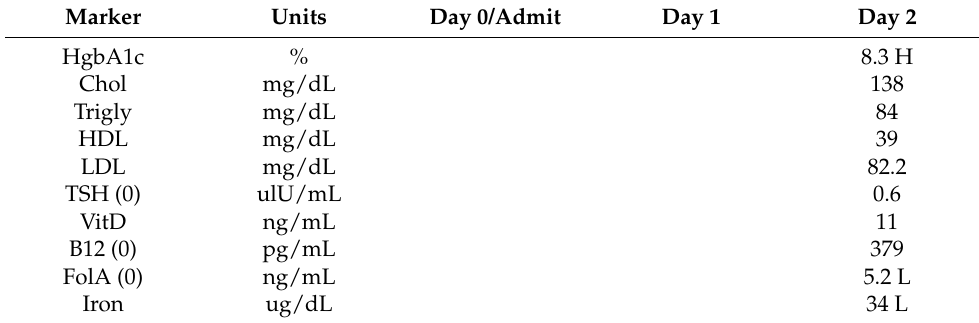
Table 3. Preventive labs profile.